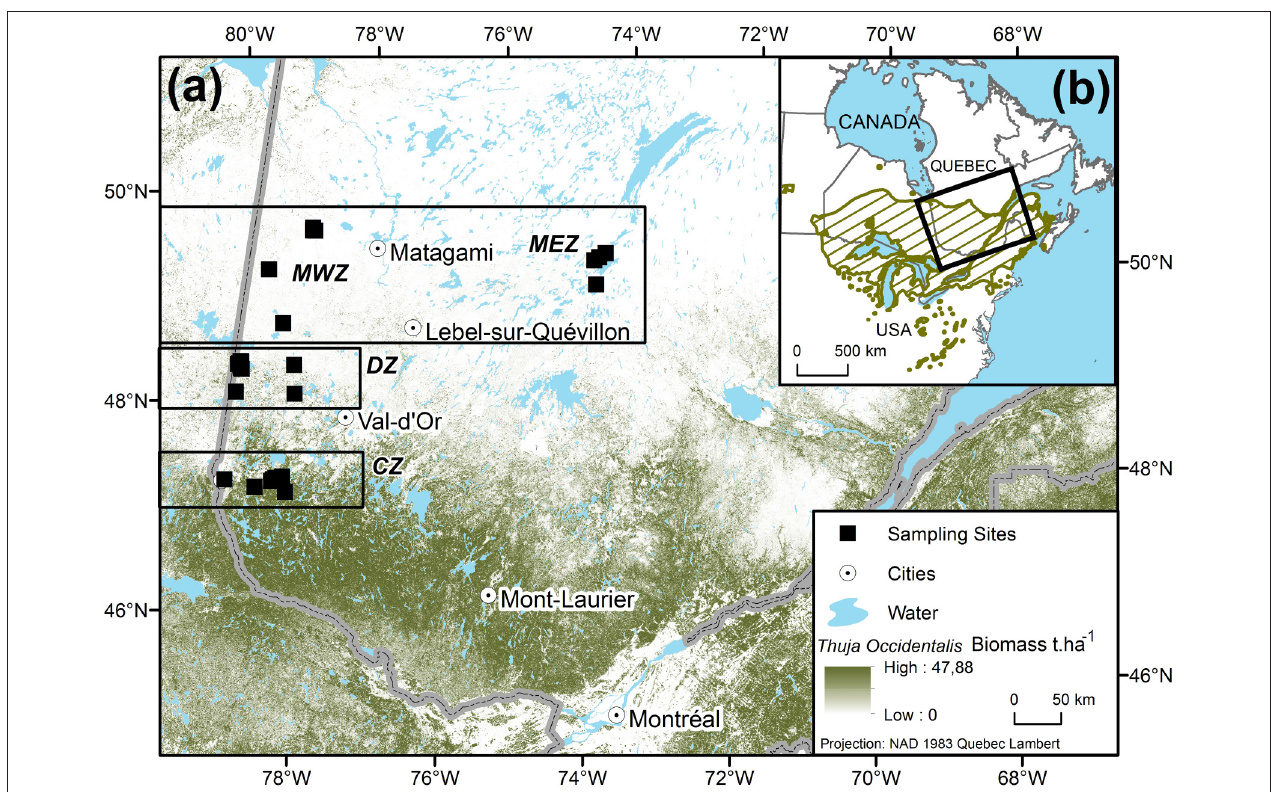
FIGURE 1 | (A) Distribution of the Thuja occidentalis sampling sites (black squares, (cid:4) ). The background shading illustrates cedar biomass in t.ha − 1 (Beaudoin et al., 2014). Sampling was stratified between the continuous zone of distribution (CZ), the discontinuous zone (DZ), and the marginal zones (MWZ for west, MEZ for east). (B) Location of the study area (outlined area) relative to the species’ range (hatched area, Little, 1971).